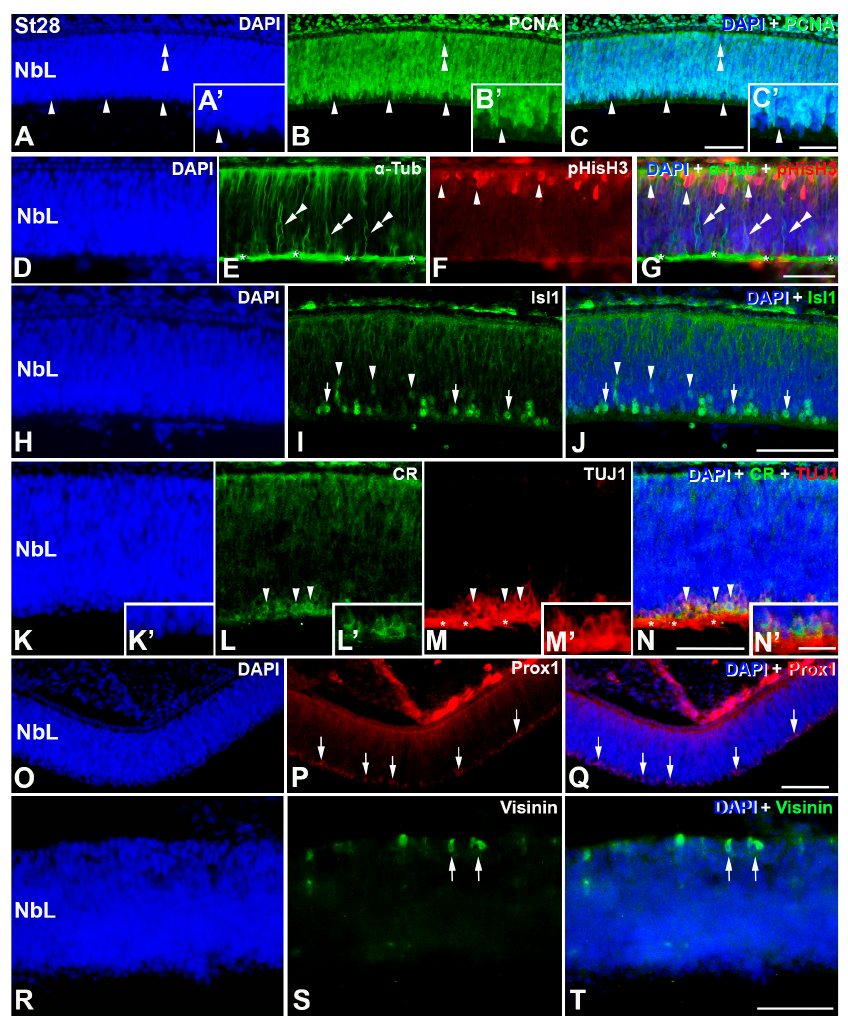
Figure 3. Detection of markers of cell differentiation in retinal cryosections of C. coturnix at St28 of development. DAPI staining reveals that quail retina is composed of a NbL at this stage ( A , D , H , K , O , R ). PCNA-immunonegative nuclei are found in the inner surface of the NbL (arrowheads in ( A – C , A (cid:48) – C (cid:48) ), but also in the outer surface of the undifferentiated retina (double arrowheads in ( A – C )). Strong α -Tub-immunoreactivity is detected in the presumptive OFL (asterisks in ( E , G )) and in the cytoplasm of migratory neuroblasts (double arrowheads in ( E , G )). pHisH3 immunoreactive mitotic figures are abundant in the scleral surface of the NbL (arrowheads in ( F , G )). Islet1 immunosignal is located in both the nuclei of migratory neuroblasts (arrowheads in ( I , J )) and cell nuclei located in the inner surface of the NbL (arrows in ( I , J )). Double immunostaining reveals that some TUJ1 immunoreactive cells located in the inner surface of the NbL also express CR (arrowheads in ( L – N ) and (K’ – N’ )). The presumptive OFL is also strongly TUJ1-immunoreactive (asterisks in M , N ). Prox1 is first detected at this stage in cell nuclei located close to the vitreal surface of the NbL (arrows in ( P , Q )). Sparsely visinin-immunoreactive cells are firstly distinguishable in the outer surface of the NbL (arrows in ( S , T )). NbL, neuroblastic layer. Scale bars: 100 µ m in A-T; 30 µ m in ( A (cid:48) , C (cid:48) , K (cid:48) – N (cid:48)